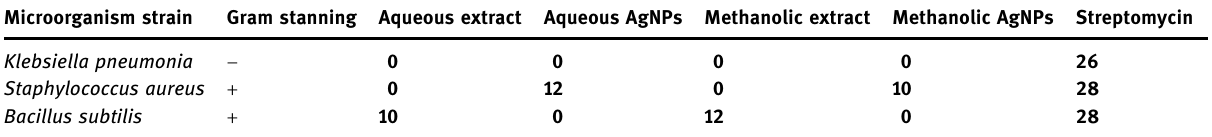
Table 3: Antibacterial activity of T. majus extract and its synthesized AgNPs Microorganism